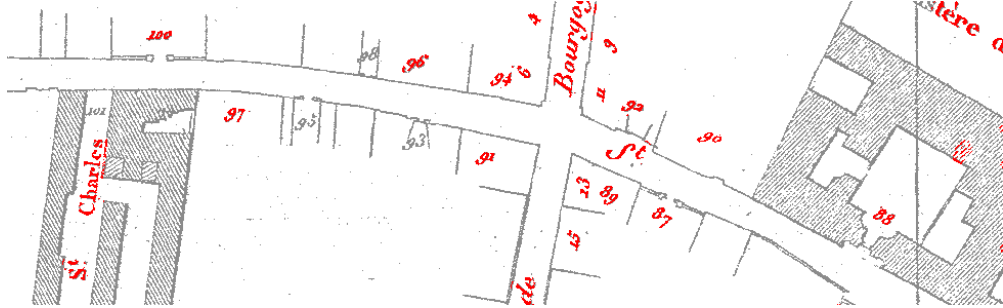
Figure 1. In this example, handwritten text is automatically detected and extracted (red) from a historical map using various image processing methods. Note that some building numbers are not